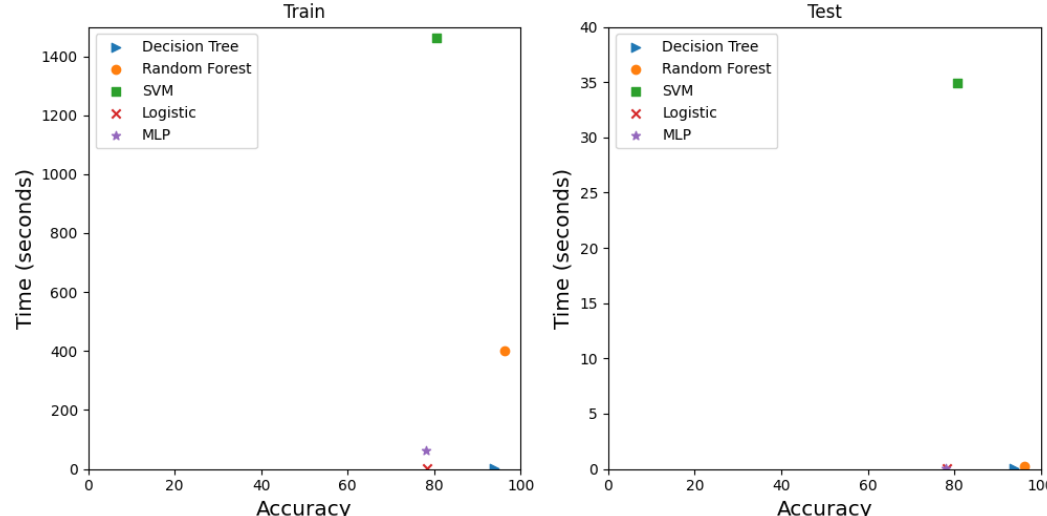
Figure 5. The training ( left ) and testing time ( right ) of the classifiers versus the